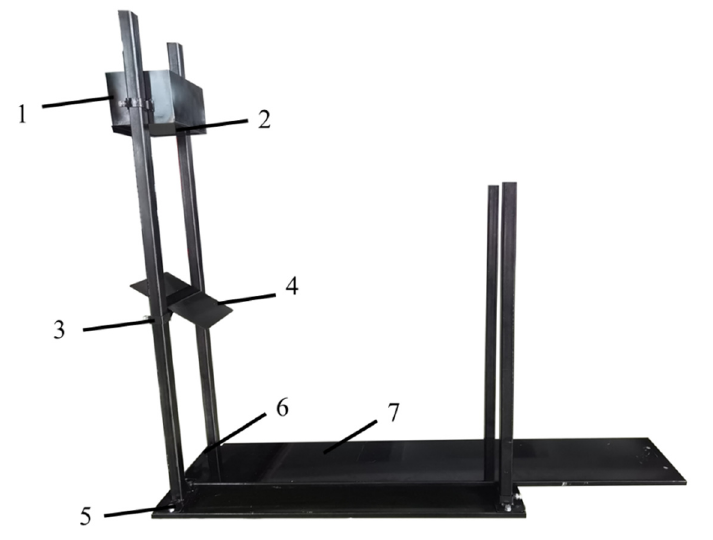
Figure 1. Rape stem contact parameters test bench. (1) Material box, (2) Baffle plate, (3) Test plate angle adjustment device, (4) Test plate, (5) Frame, (6) Base plate angle adjustment device, and (7) base plate.